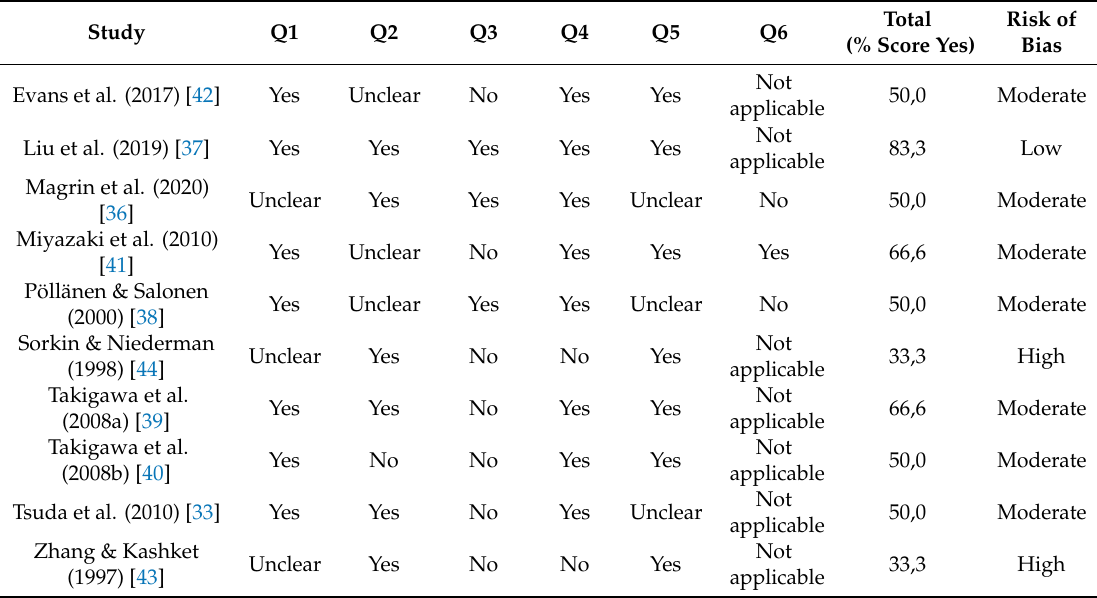
Table 2. Risk of bias in individual studies assessed by the adapted tool of the World Cancer Research Fund / University of Bristol for cell line studies ( n =